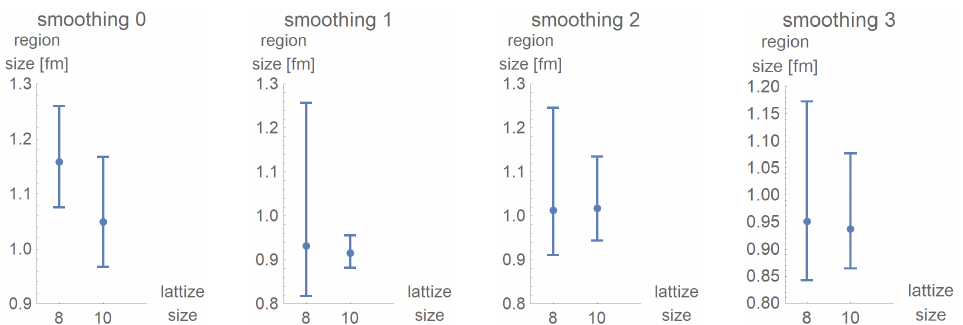
Figure 13. With two cooling steps, an increase in the size of homogeneous regions becomes apparent, but the big error bars of the respective data do not allow a precise